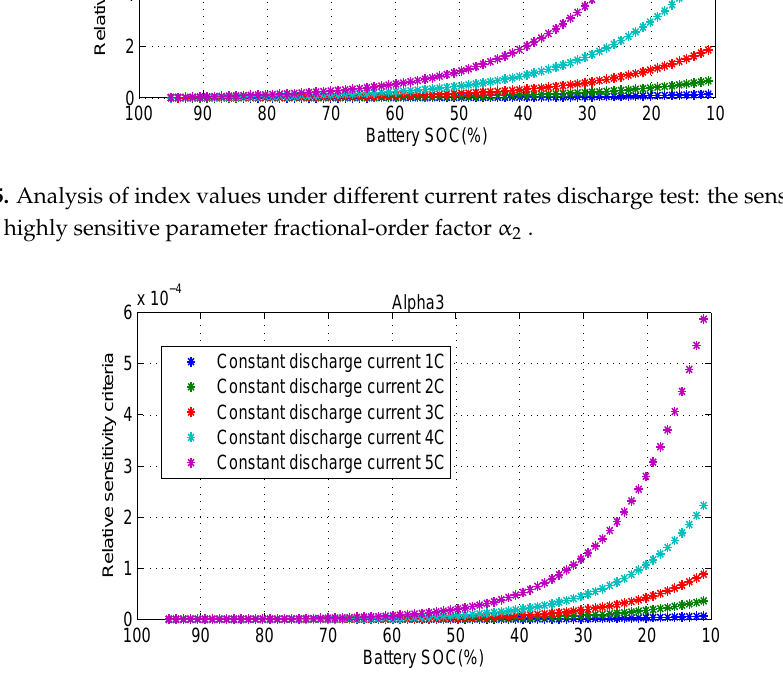
Figure 16. Analysis of index values under different current rates discharge test: the sensitivity index values of insensitive parameter fractional-order factor α 3 .